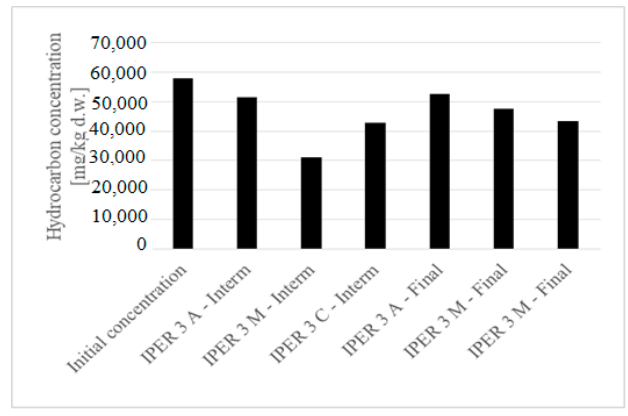
Figure 3. The behavior of hydrocarbons during ER (IPER—Pilot installation for electroremediation).